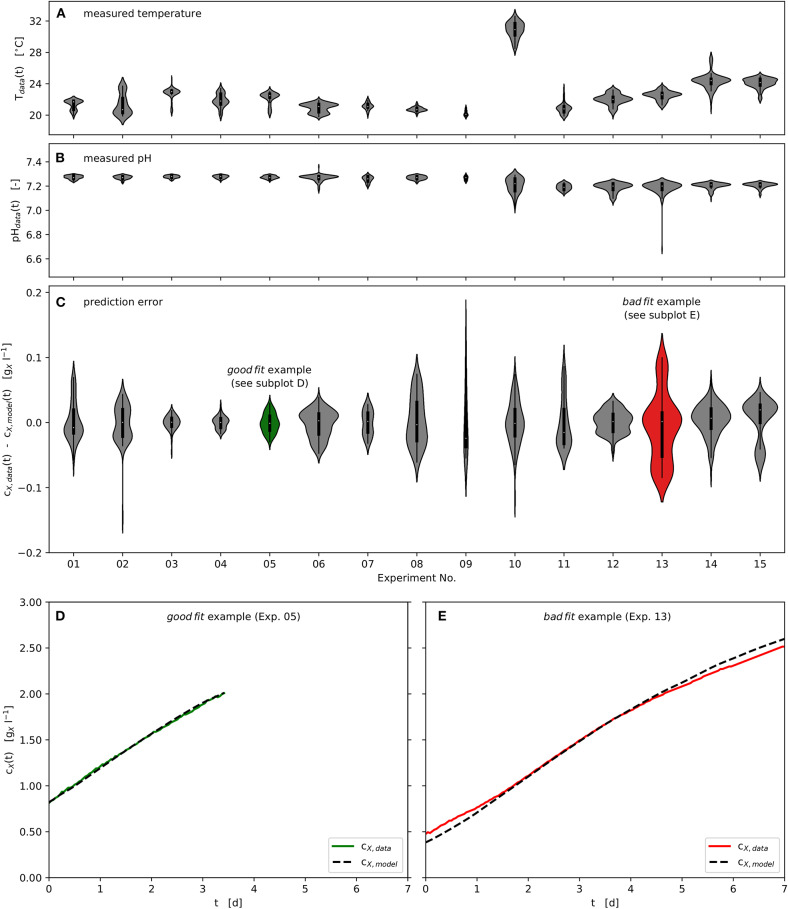
Experimental and modeling results: Time series of measured and modeled biomass concentration, measured temperature and pH; Violin plots: center point - median, box - interquartile range (IQR), whisker - 1.5 · IQR, kernel density estimation - number of observations; (A): Temperature distributions of the experimental time series data; (B): pH distributions of the experimental time series data; (C): Model prediction error distributions of the experimental time series data with respect to biomass concentration; (D): “good fit” example - representing lowest prediction error calculated, Experiment No. 05; (E): “bad fit” example - representing highest prediction error calculated, Experiment No. 13.